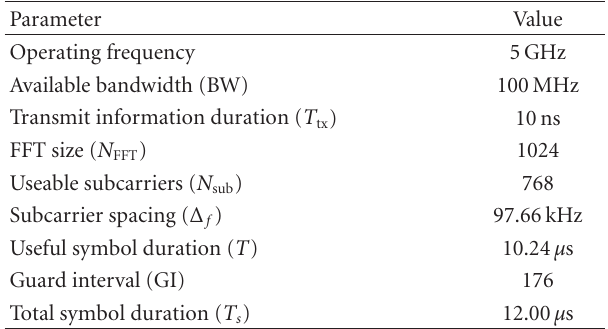
Table 1: Physical layer parameter for OFDM